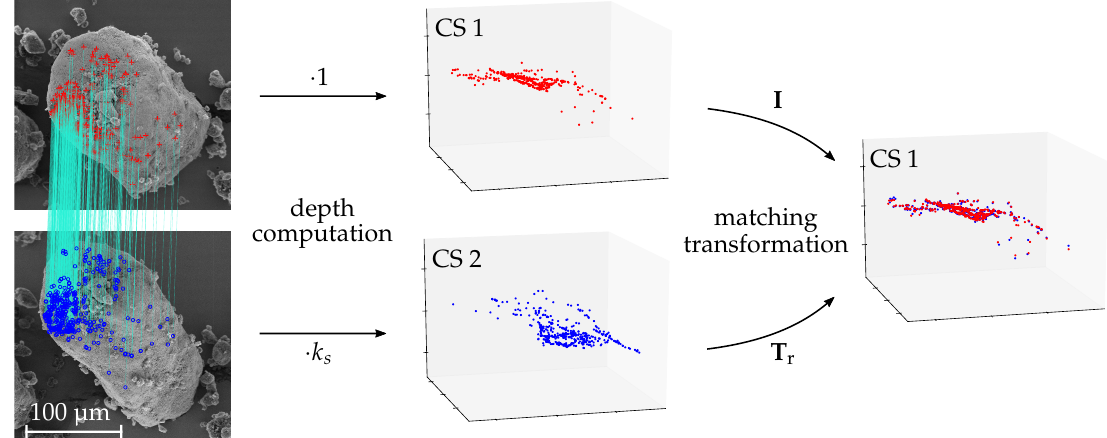
Figure 9. Computation of the rigid transformation T r for the initial alignment of the dense point clouds. The blue point set is scale adjusted and the computed transform maps it onto the red point